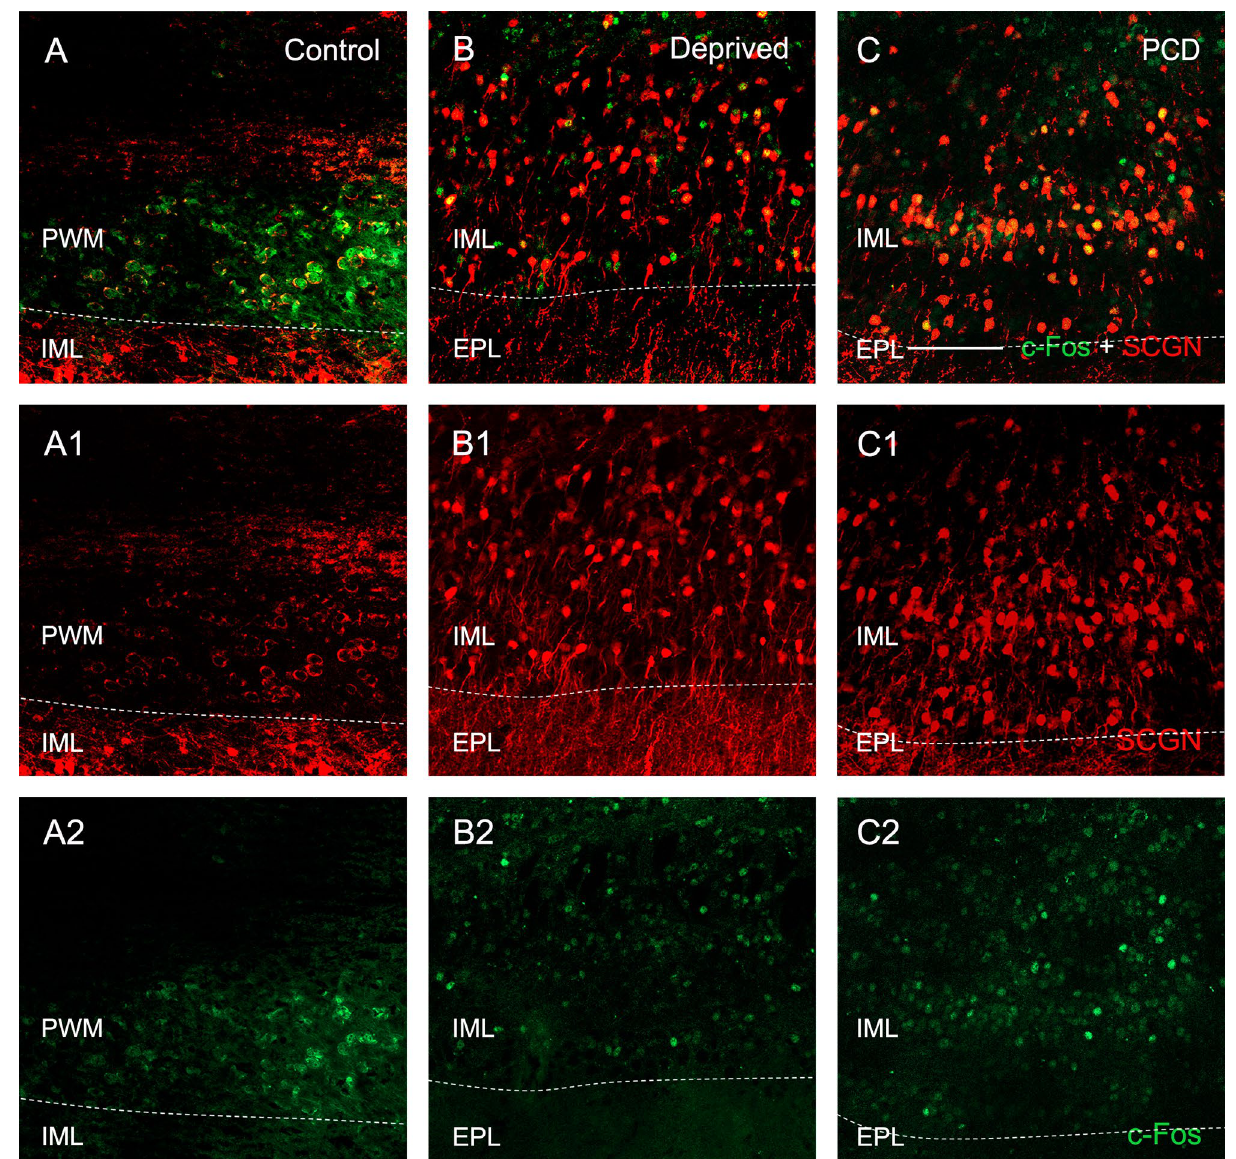
Figure 6. Expression of SCGN (red) and c-Fos (green) in control ( A ), deprived ( B ) and PCD ( C ) mice. The separate channels are also shown for SCGN ( A1 – C1 ) and c-Fos ( A2 – C2 ). In the control mice, c-Fos-positive cells are only observed in the periependymal white matter (PWM) and show a large nucleus and a small cytoplasm ( A ). In deprived ( B ) and PCD ( C ) mice, double immunopositive cells for c-Fos and SCGN appear in all strata, mainly in inframitral layers (IML) and the glomerular layer (not shown), being very scarce in the external plexiform layer (EPL). Scale bar 100